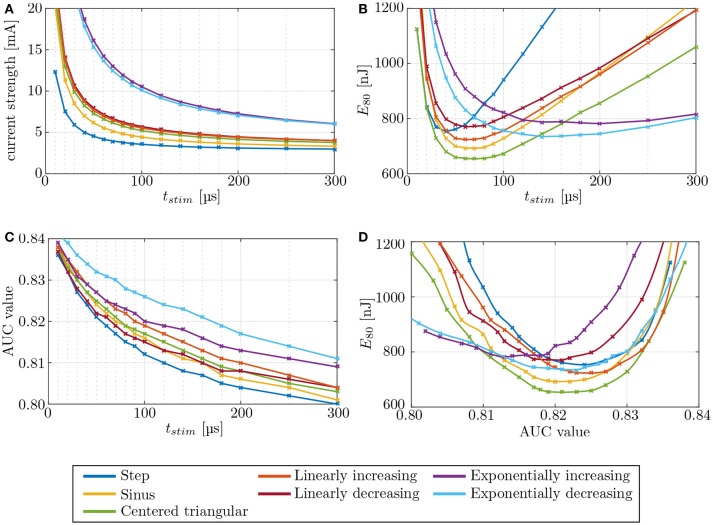
Evaluation of different stimulation waveforms of the electrode configuration i11–i15, located in the anterior SCC. Stimulation phase duration is systematically increased from 10 μs to 500 μs. Since phase durations longer than 300 μs did not offer any advantages, they are not displayed. Phase duration dependencies of (A) current strength, (B) energy, and (C) selectivity were recorded. The strength-duration curve and the consumed energy E80 were computed at (80 %) target nerve activation. Panel (D) shows the required energy expenditure to reach a certain level of selectivity. The crosses mark the different pulse durations.